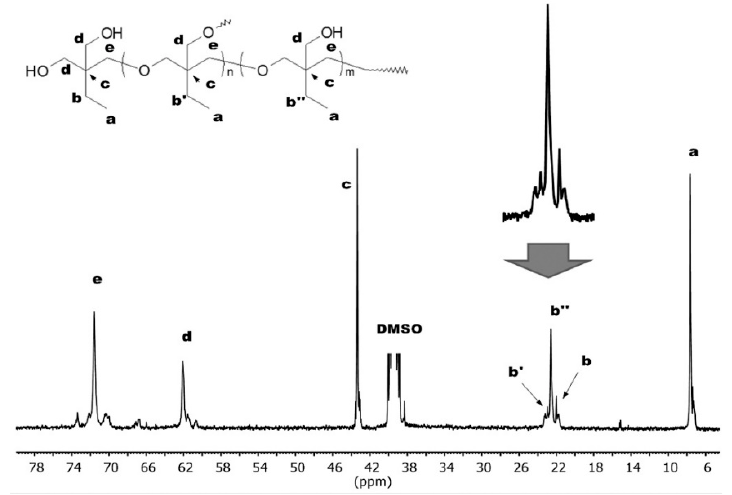
Figure 3. 13 C NMR (400 MHz, DMSO-d 6 ) spectrum of poly(3-ethyl-3-hydroxymethyloxetane) of degree of branching equal to 0.36. Table 1. Molar mass and amounts of reagents used in synthesis of polyoxetanes (POXs). Theoretical Molar Mass [g/mol]